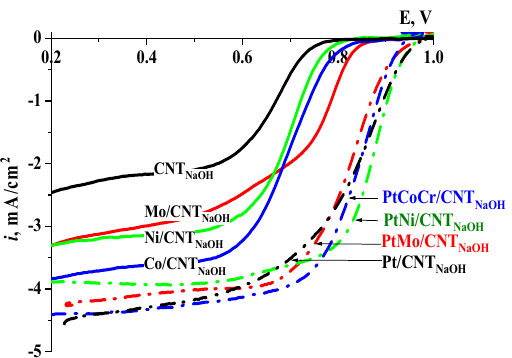
Figure 5. Polarization curves on studied catalysts in 0.1 M KOH; O 2 ; 0.005 mV/s; m cat = 0.15 mg/cm 2 , w = 1500 rpm.